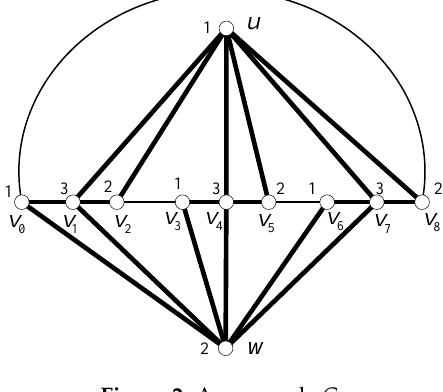
Figure 2. An example G 3